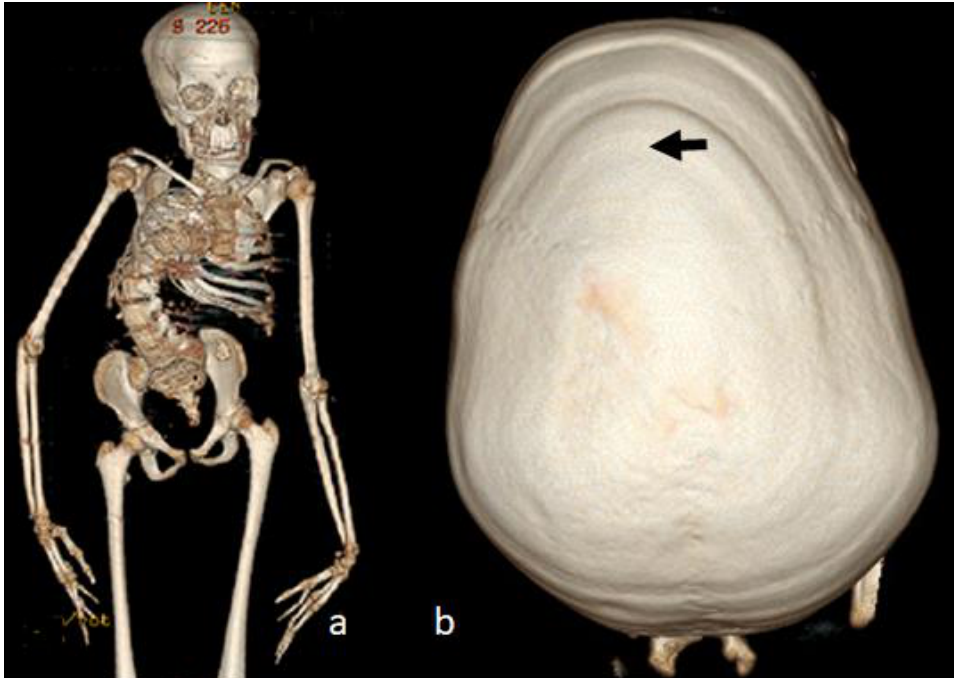
Figure 8. A 12-year-old girl was referred because of scoliosis associated with multiple contractures. Three-dimensional phenotype reconstruction was applied to explore the skeletal system in full details ( a ). She manifested the full clinical criteria of Marfan-like syndrome ( a ). Long, thin limbs, arachnodactyly, multiple contractures and principally progressive kyphoscoliosis, with a Cobbs angle of 90° ( a ). Three-dimensional reconstruction carried out to explore the crown of the skull showed asymmetrical development associated with closure of the sagittal suture (arrow) ( b ).